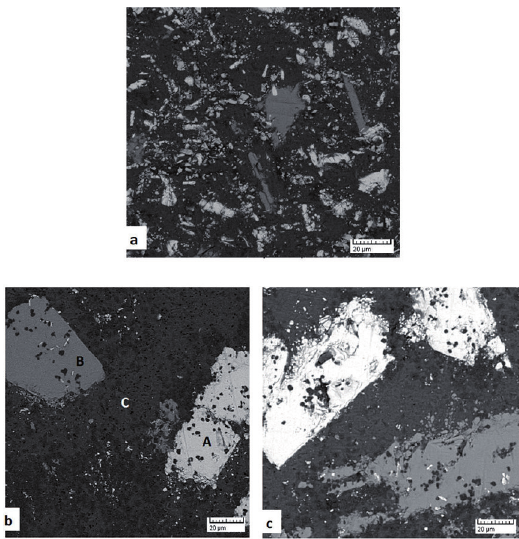
Figure 5: SEM photograph of aluminum-zircon composite (a) DM-550, (b) DM-2, (c) DM-4